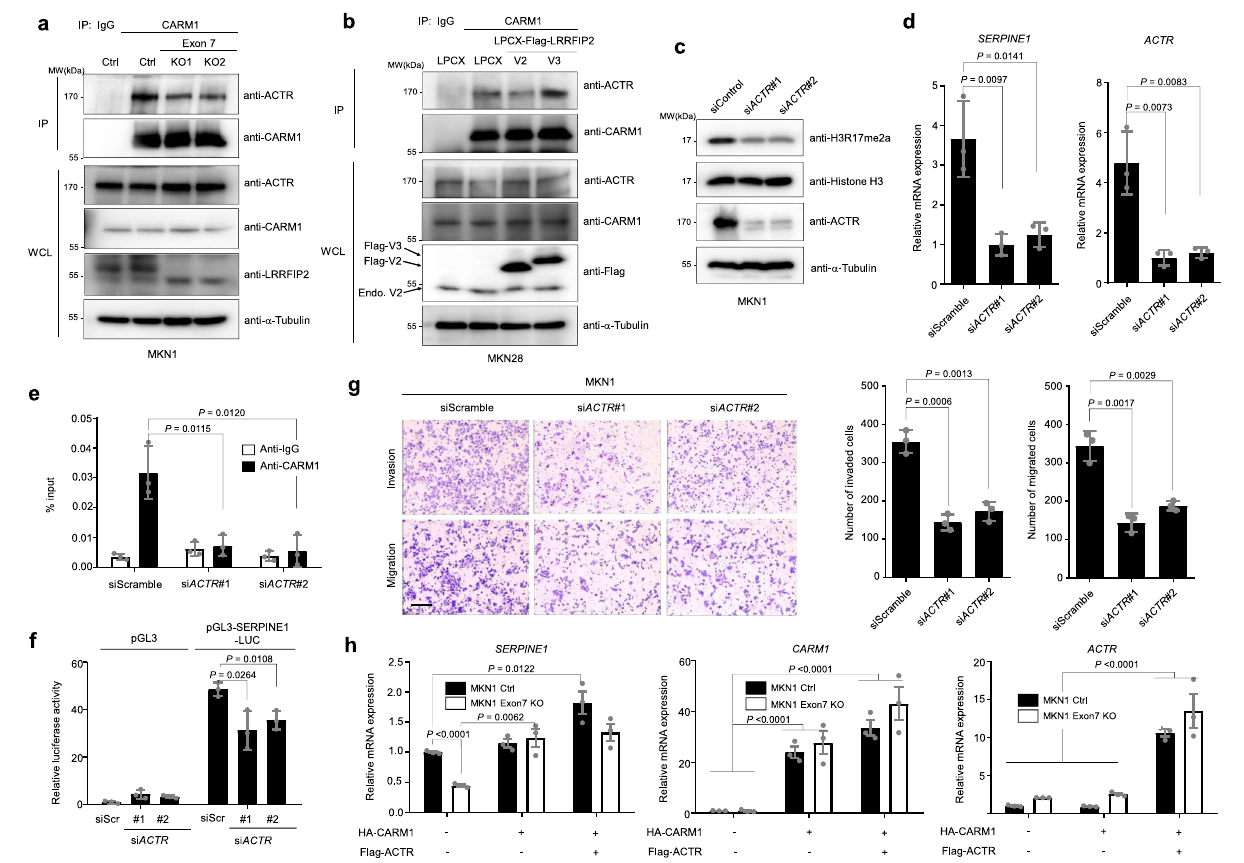
Fig. 5 | CARM1 and the p160 coactivator ACTR/SRC3/AIB1/NCOA3 cooperate fortranscriptionalregulationof SERPINE1 .a Immunoprecipitationassayshowing the interaction betweenendogenous CARM1 and membersof ACTR incontroland exon7-deleted MKN1 cell lines and RT-PCR analysisshowing expression of LRRFIP2 variants. b Immunoprecipitation assay showing the interaction between endo- genous CARM1 and members of ACTR in LRRFIP2 variants 2 and 3-overexpressing MKN28 cell lines. c Immunoblot analysis showing expression of H3R17me2a and ACTR following knockdown of ACTR in MKN1 cells. d RT-PCR analysis showing expression of SERPINE1 and ACTR following knockdown of ACTR in MKN1